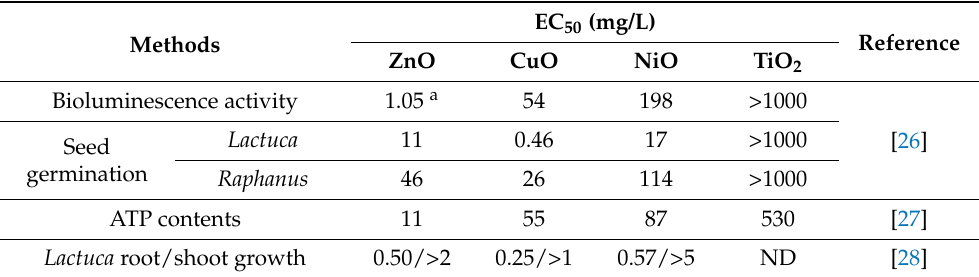
Table 2. Summary of previously published results of the effects of NPs on various biological activities in this